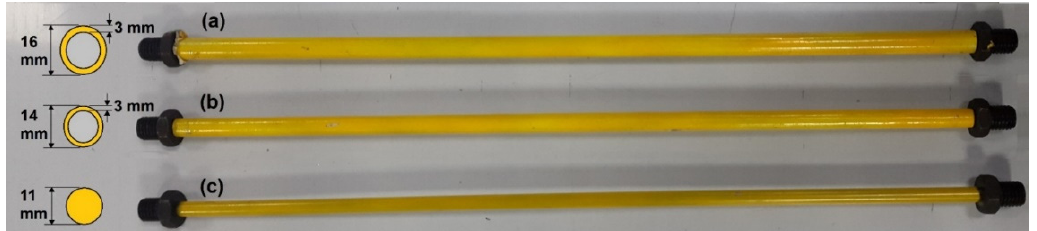
Figure 4. Details of the damaged elements with; ( a ) 20%, ( b ) 50%, and ( c ) 80% reduced percentages of the cross-section stiffness.